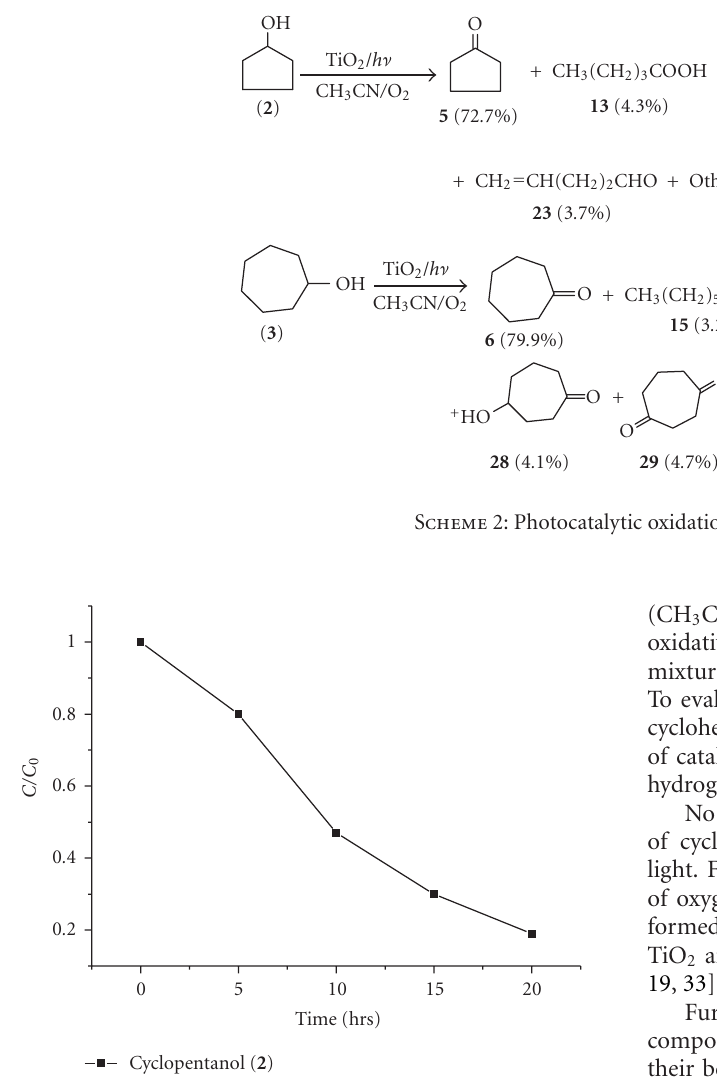
Figure 8: Photocatalytic disappearance of 2 in acetonitrile.